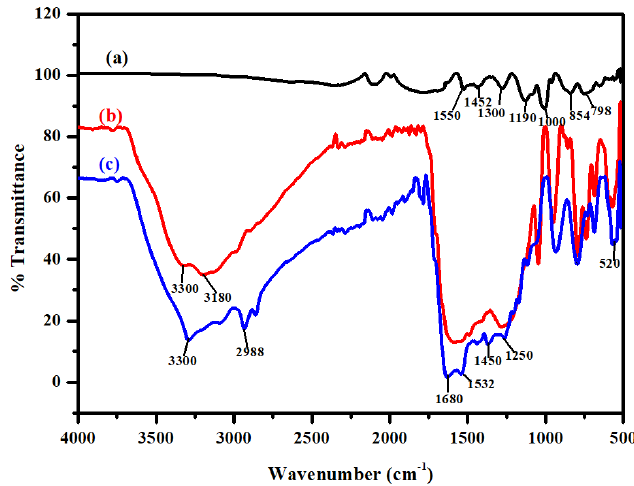
Figure 3. Fourier transform infrared (FTIR) spectra of PPy ( a ), PPy- m PD / Fe 3 O 4 nanocomposite before ( b ) and after ( c ) Cr(VI) adsorption.